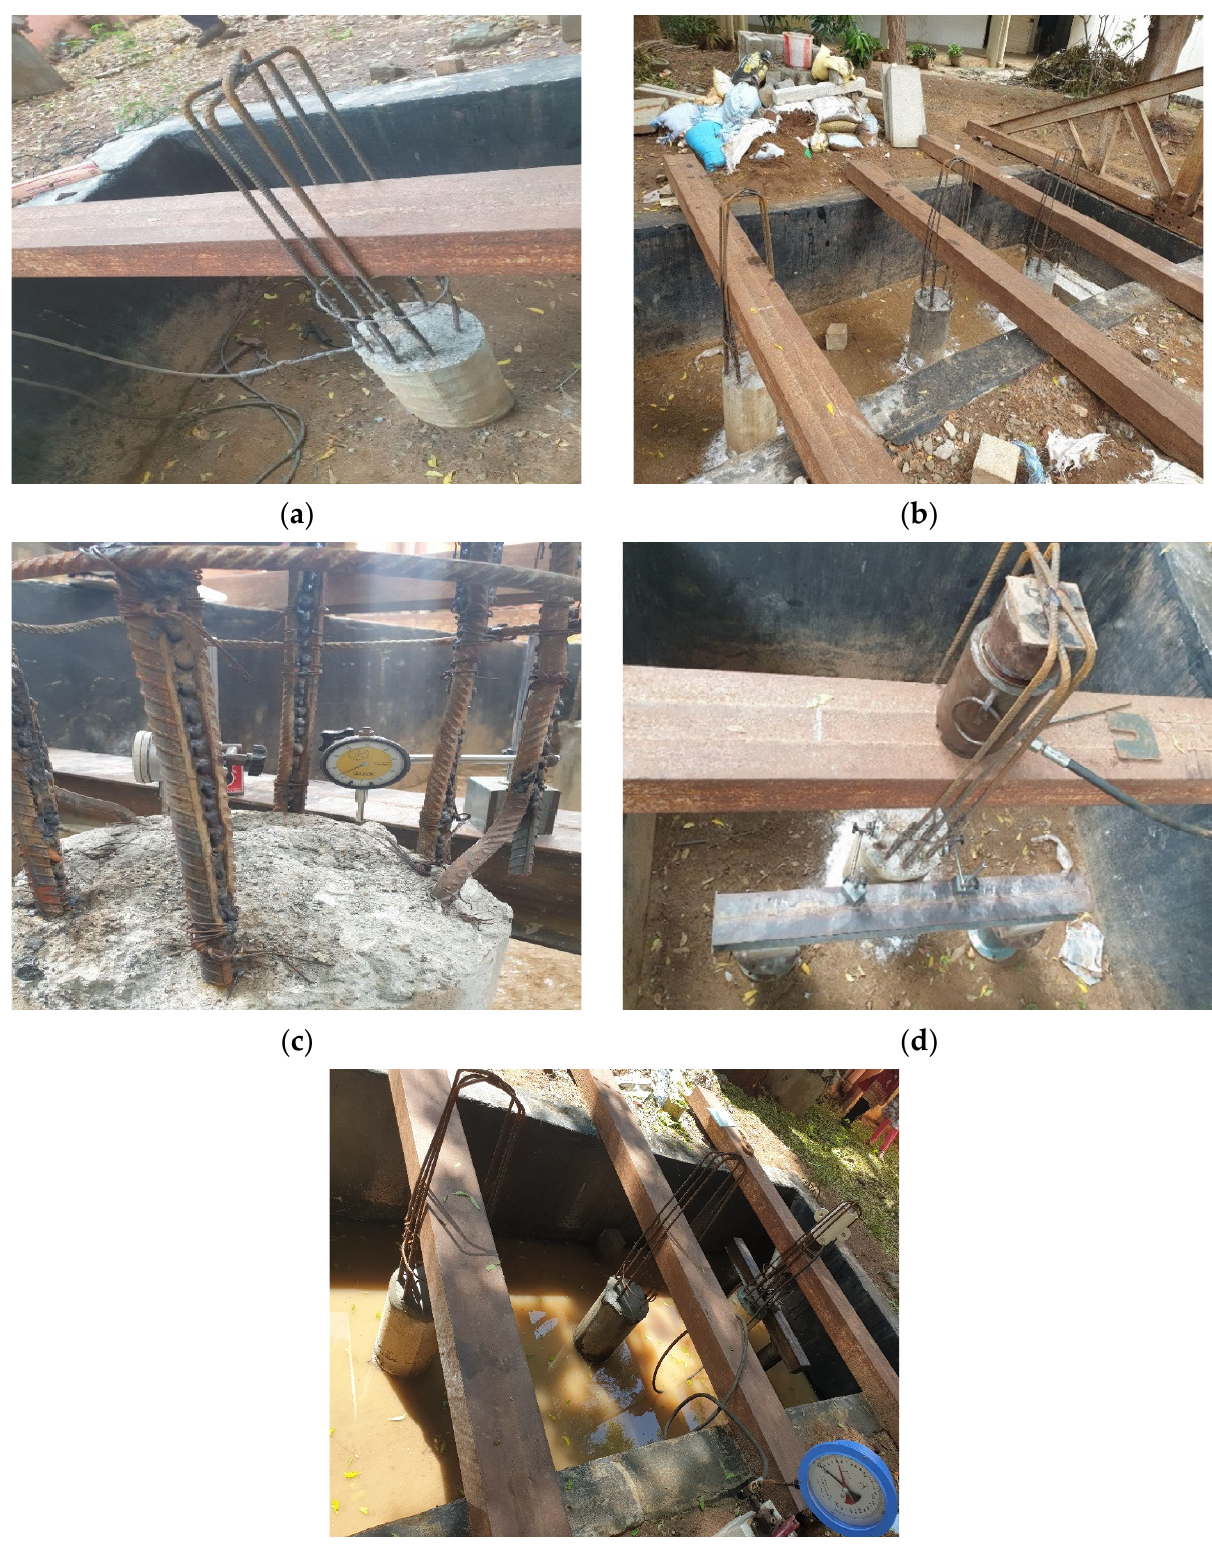
Figure 8. Uplift resistance test setup: ( a ) welding of the reinforcement; ( b ) installation of the reaction girder; ( c ) installation of the dial gauges; ( d ) final setup in a dry state; ( e ) final setup in a submerged state.